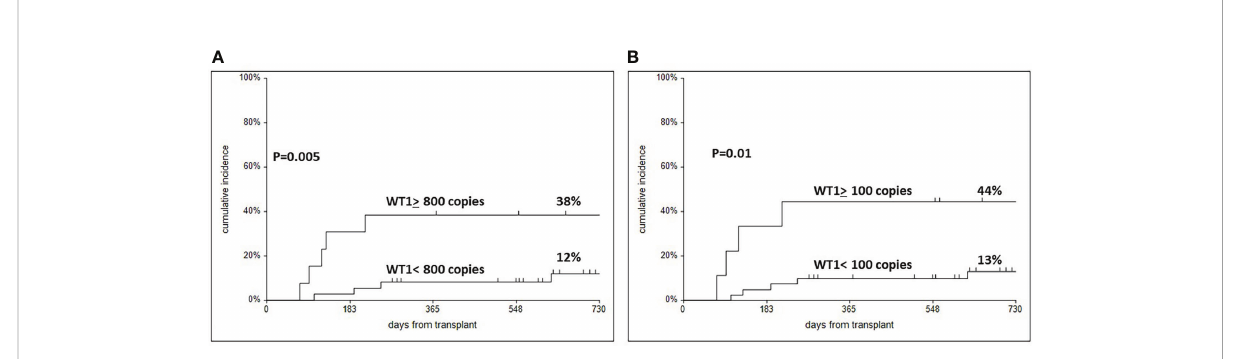
FIGURE 3 Cumulative incidence of relapse in patients according to WT1 expression in CD34 selected cells (A) with a cut off of 800, and in unmanupulated mononuclear cells with a cut off of 100 (B) .